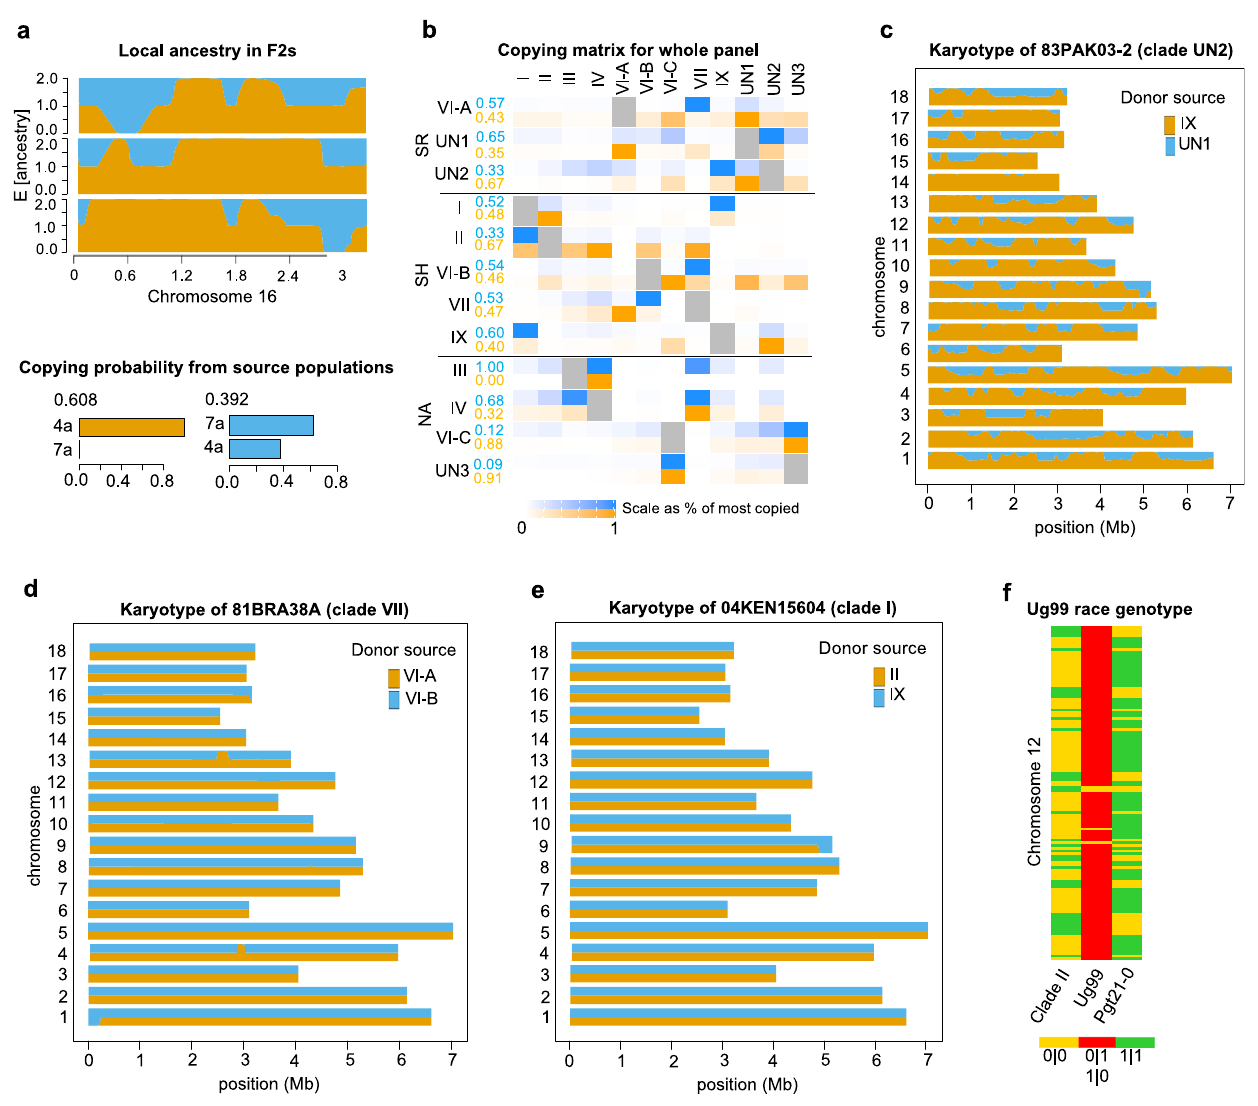
Fig. 6 | Analysis of local ancestry using MOSAIC. a Local ancestry of three F 2 isolates along chromosome 16 (top panel) expressed as the probability of copying (E[ancestry])fromthetwoparentalisolates4Aand7A(bottompanel).Thebottom panel ’ s x-axis shows the copying probabilities of two ancestries from isolates 4A and7A.Theproportionsofancestryinthetwo-wayadmixturemodelinthesample of three isolates is shown on the top (0.608 and 0.392). b Copying matrix for the clades in the Pgt panel modeled as two-way admixture. Row names show clades used as target panels, and columns show reference panels. The proportions are scaled as % of the most copied within rows. The numbers listed on the left are the averaged copying proportions across the reference panelsin a two-wayadmixture model. Based on the analysis of the local ancestry of individual Pgt isolates, we